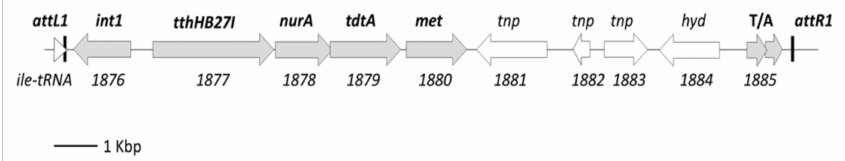
Figure 1. Integrative and conjugative element (ICETh1) structure. A map depicting the genes encoded by ICETh1 is shown. Integration repeats attL1 and attR1 , and genes for which biochemical and / or genetic evidences exist regarding their function are labeled in bold and the arrows in gray. The code number of the genes in the chromosome of T. thermophilus HB27 is located below the corresponding